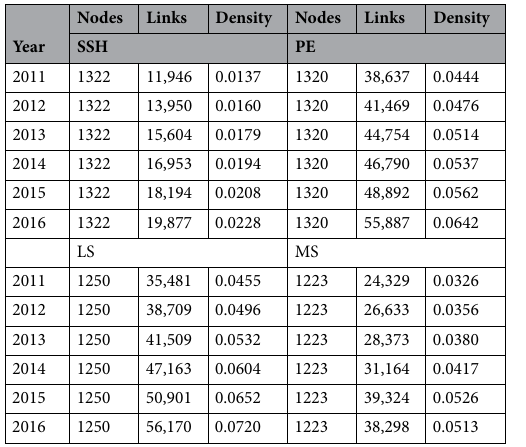
Table 1. Descriptive statistics for the European universities’ co-publication network. Data by year and scientific domain.